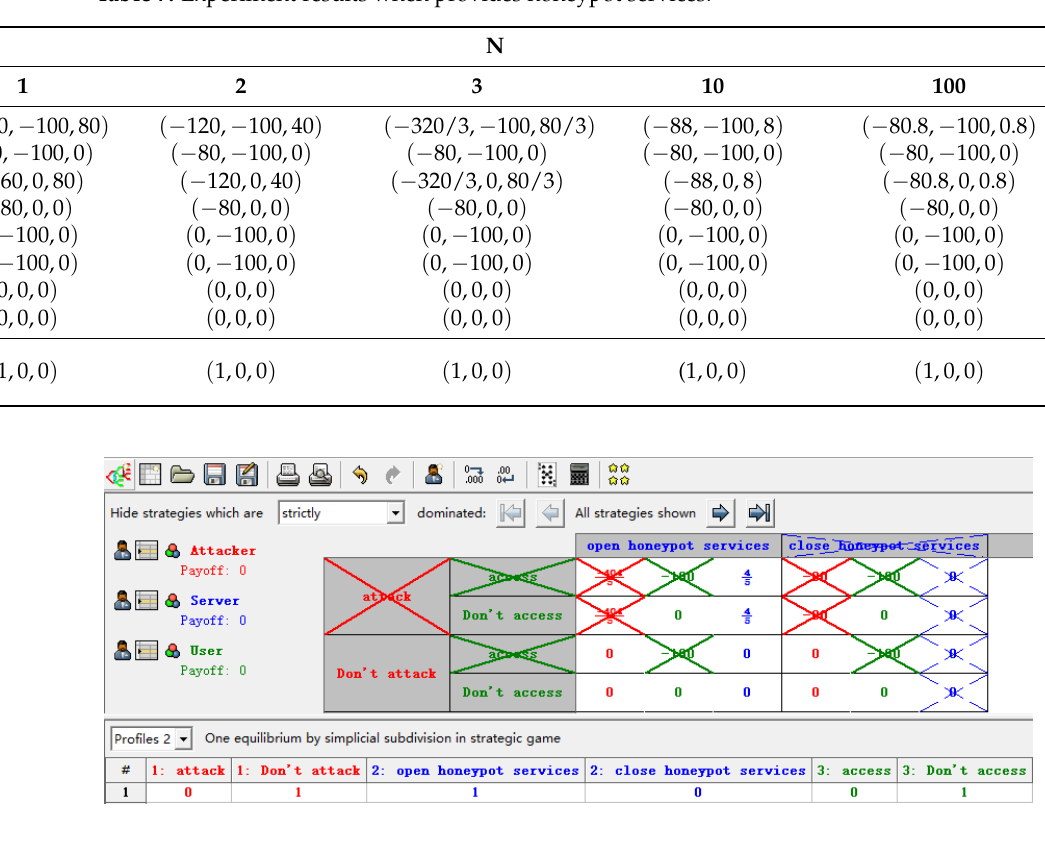
Figure 4. The stabilized Gambit experiment result of honeypot